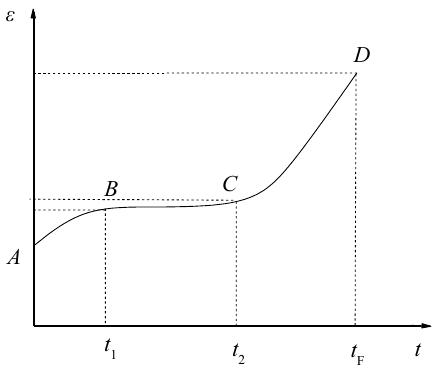
Figure 1. Typical creep